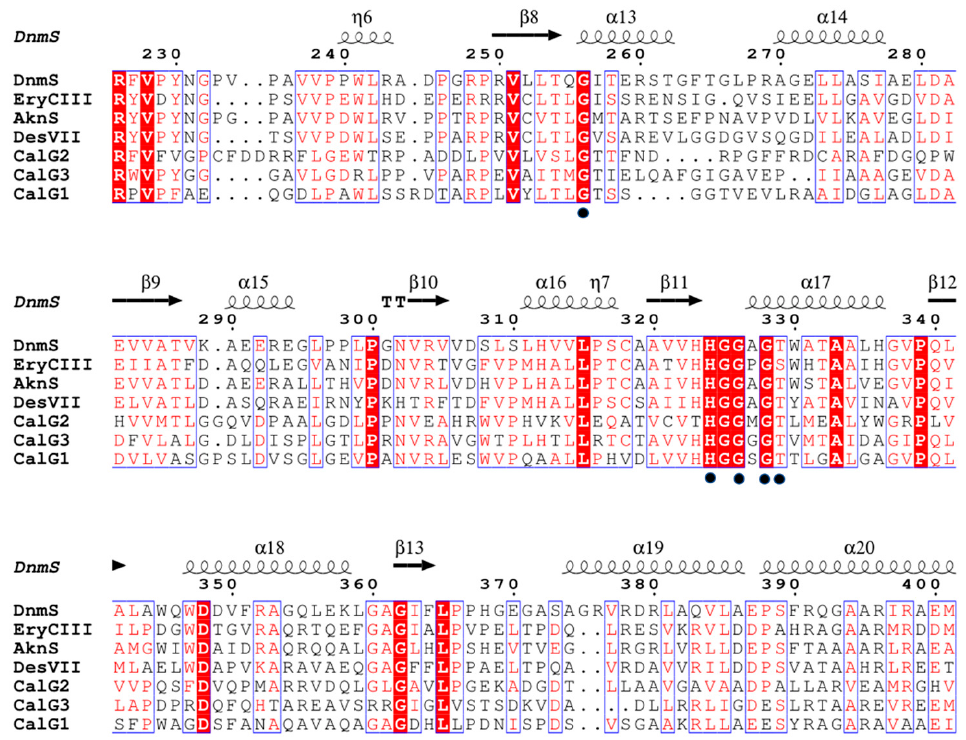
Figure 7. DnmS homologous sequence alignment. EryCIII (AAB84067.1 PDB entry: 2YJN) from Saccharopolyspora erythraea involved in the biosynthesis of erythromycin; AknS AF264025 involved in the biosynthesis of the macrolide antibiotic aclacinomycin A; DesVII (AAC68677.1) involved in the biosynthesis of the macrolide antibiotics methymycin, neomethymycin, narbomycin and pikromycin; CalG1 (PDB entry: 3OTG), CalG2 (PDB entry: 3IAA) and CalG3 (PDB entry: 3D0Q) from Micromonospora echinospora involved in the biosynthesis of enediynecalicheamicin. Secondary structural elements in the structure of DnmS are represented above the multiple-sequence alignment. The highly conserved residues are shaded in red, residues not fully conserved are represented by blue boxes, and comparative residues are indicated by black circles. Multiple-sequence alignment was performed using ClustalX and edited with ESPript.